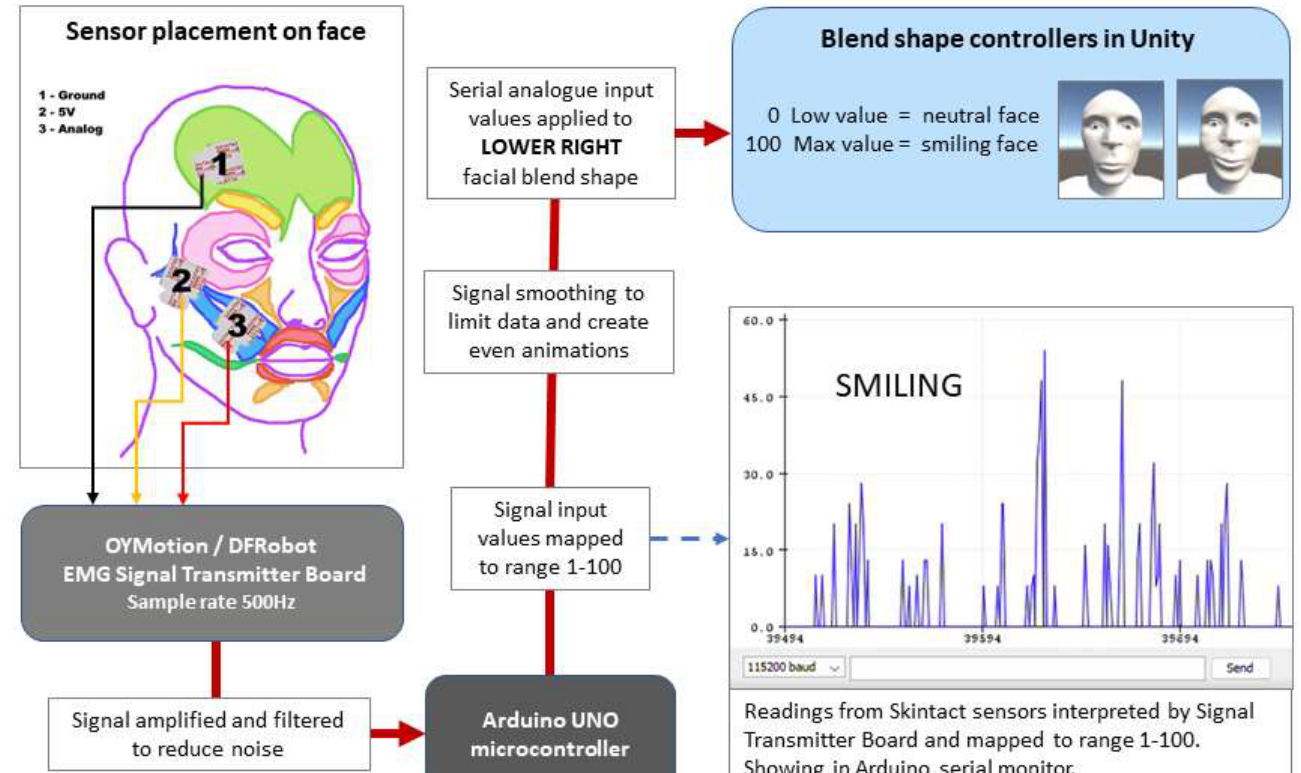
Figure 9. Final process: The EMG signal is filtered and mapped to a range 1–100, which is then used as input to the Unity application and used to manipulate blendshape animations.